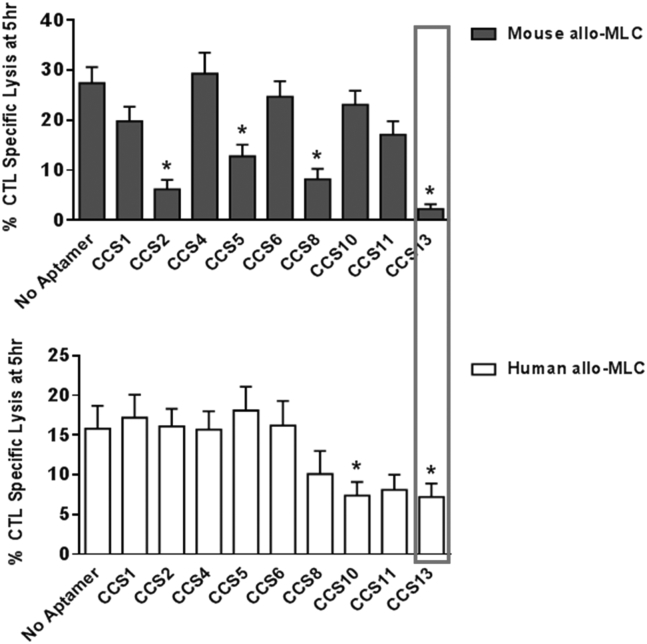
CCS13 Is a Cross-Species AgonistThe DNA aptamer CCS13 was the only common aptamer motif identified that was able to act as a CD200R1 agonist, suppressing allo-immune responses in both murine and human MLCs. Each bar represents the mean % value of CTL specific lysis ± SD. *p < 0.05, as compared to no aptamer.